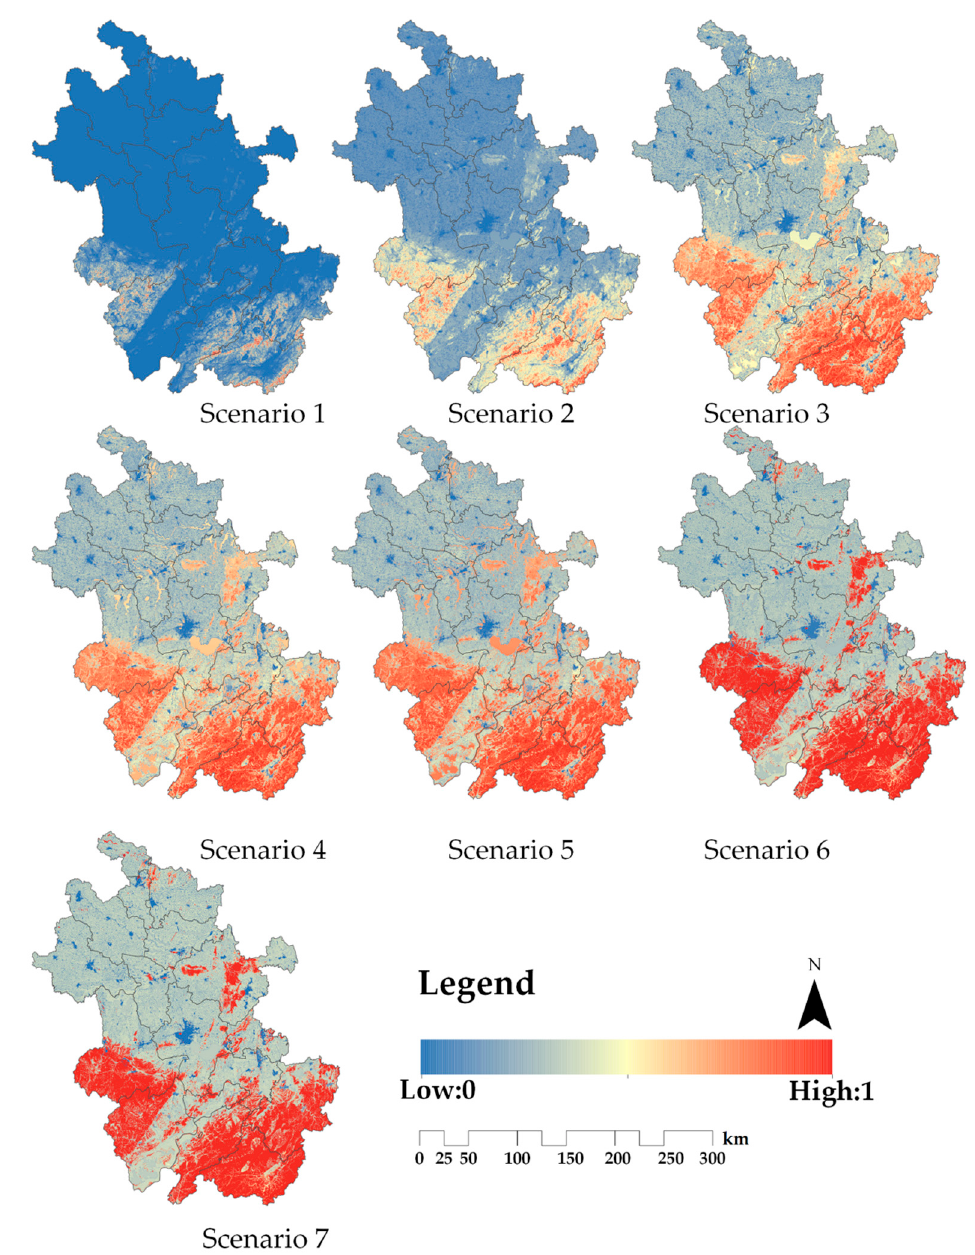
Figure 5. Spatial patterns of integrated ecosystem service values for seven different scenarios in Anhui Province.